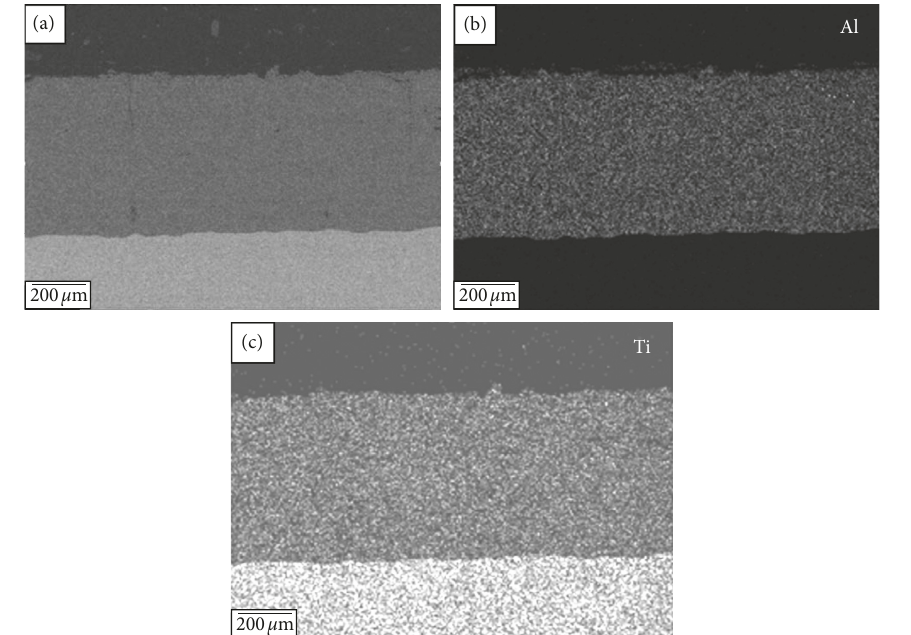
Figure 5: (a) Cross-sectional BSD image of Al coating after testing for 5 hours at 1073K and the distribution of (b) Al and (c) Ti.